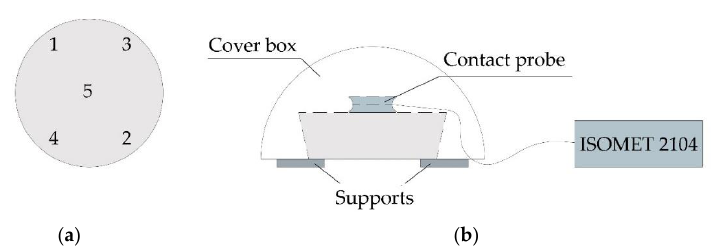
Figure 2. ( a ) Points where thermal conductivity was calculated; ( b ) Method to calculate thermal conductivity (adapted from Cintura et al.